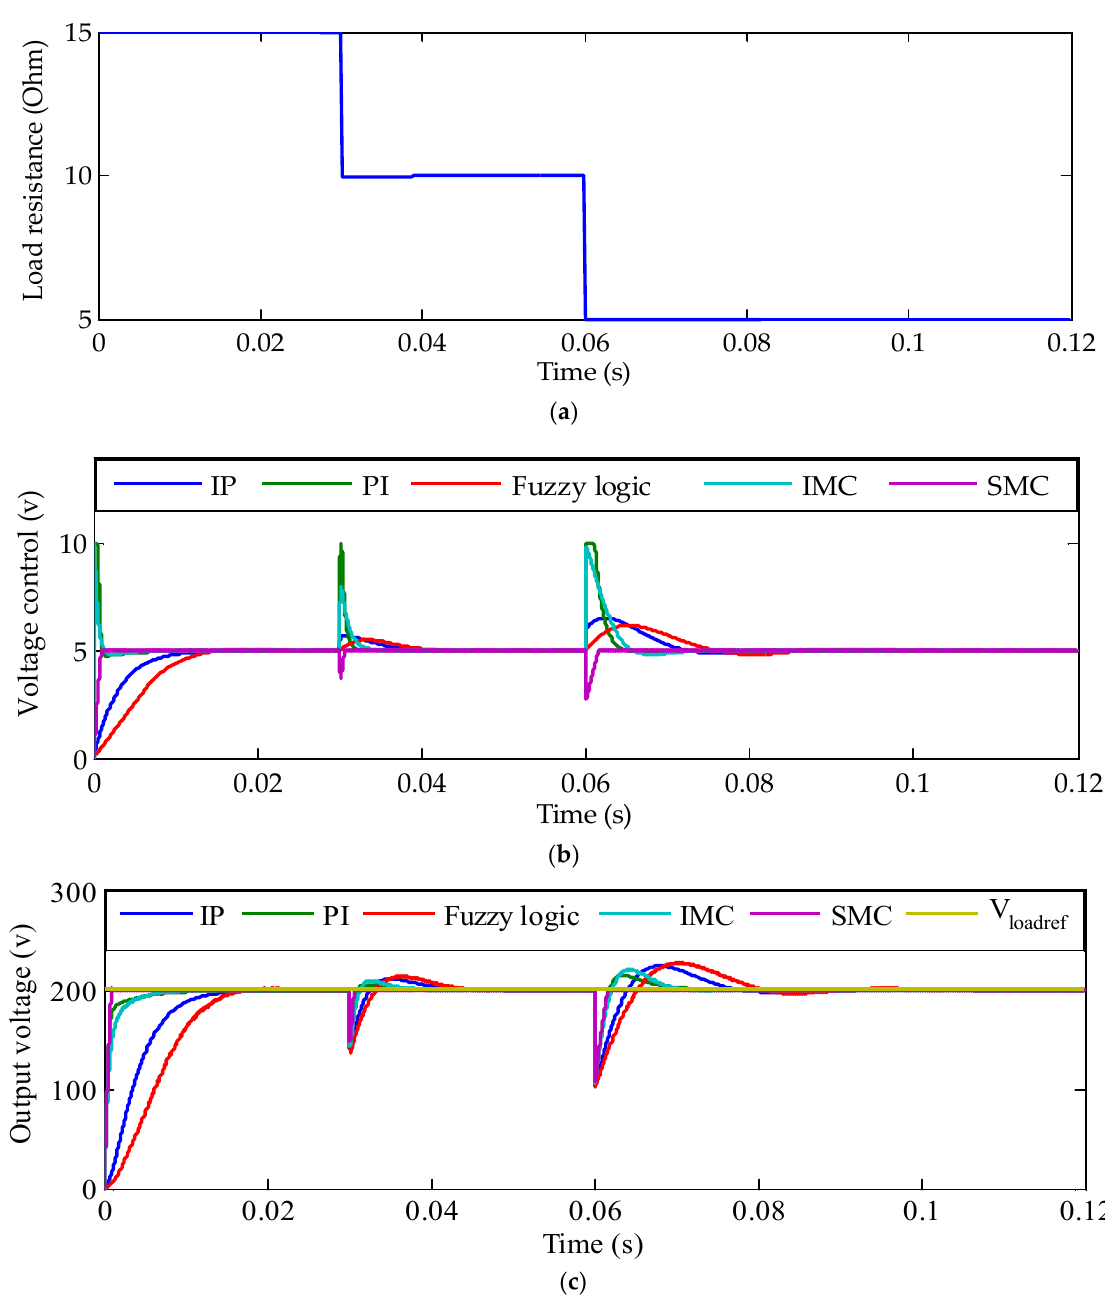
Figure 11. Resistor load variation: ( a ) evolution of the control voltage and ( b ) evolution of target and ( c ) actual output voltages.